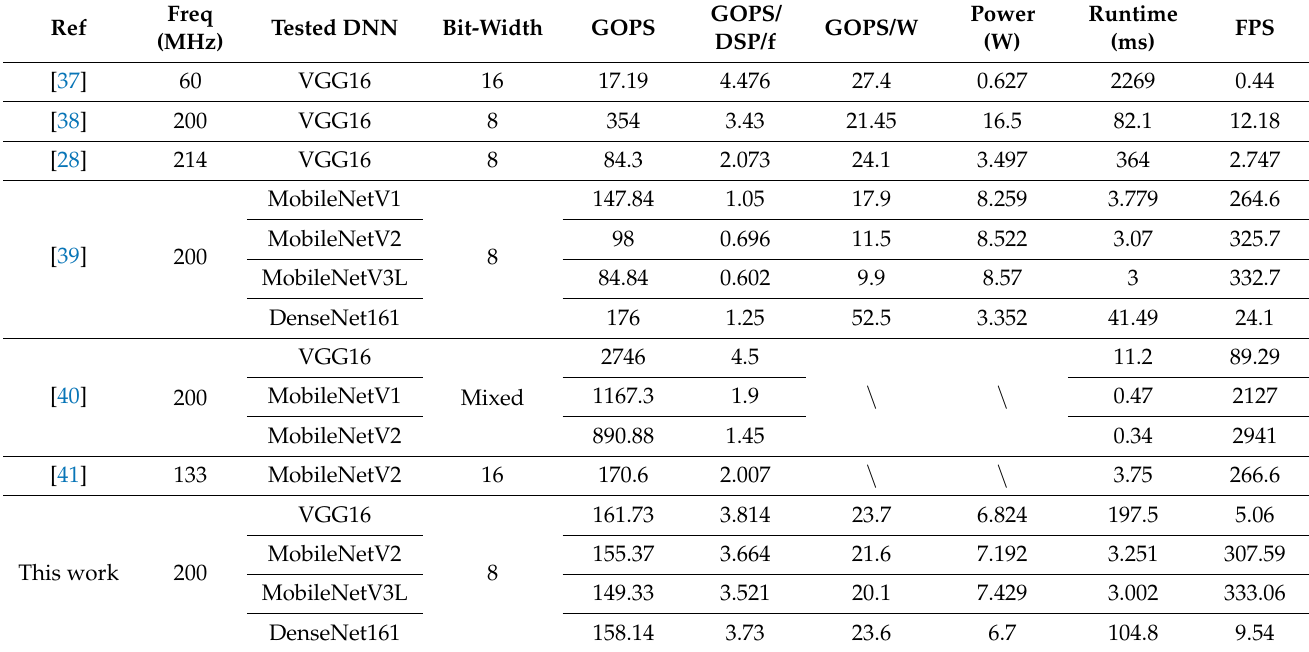
Table 4. The experiment results for CNNs on the proposed VPU and the comparison with the previous